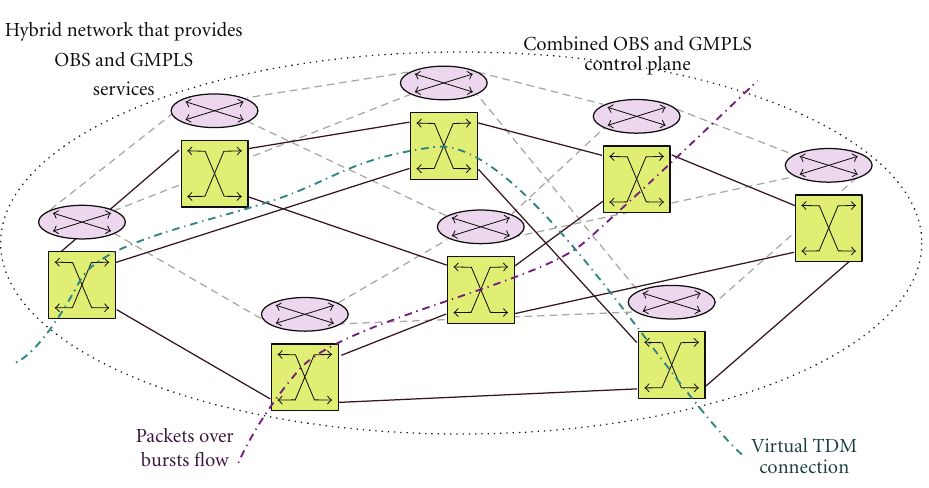
Figure 16: Integrated GMPLS/OBS control merging the merits by integrating native OBS control in GMPLS.